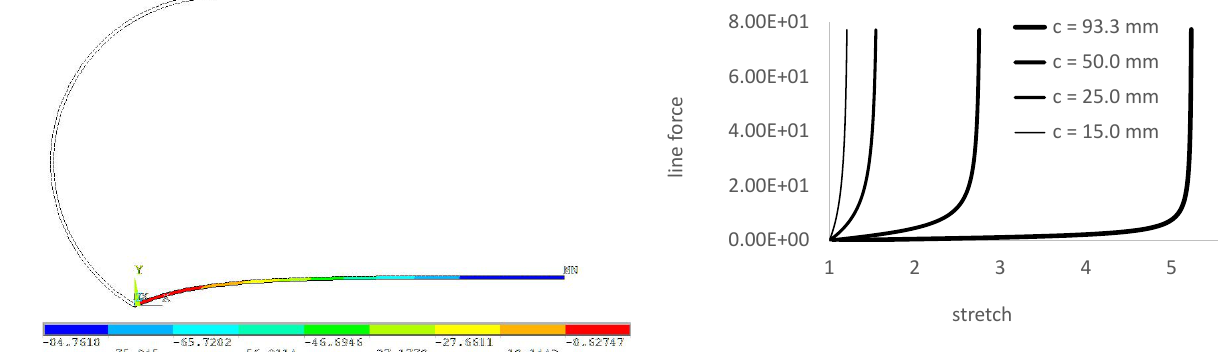
deviation between the two displacements, where the FEM result is used as reference, is −0.7%. If the vertical dis- placement is considered rather than the position, the rel- ative deviation is one order of magnitude smaller.